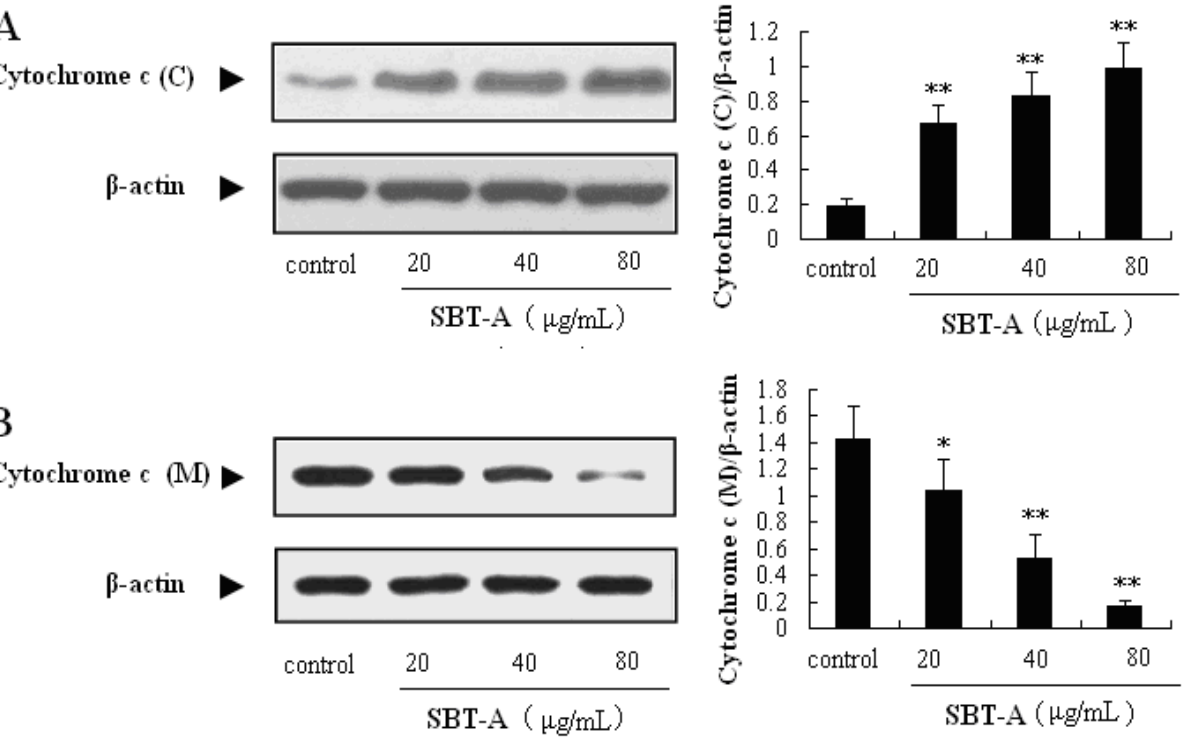
Figure 5. Effects of SBT-A on expressions of cytochrome c, cleaved-caspase-3 (C-capase-3), and cleaved-caspase-9 (C-caspase-9) proteins on A549 cells. Cytochrome c (C) and cytochrome c (M) mean expressions of cytochrome c in cytoplasm and mitochondria, respectively. A549 cell lines were treated with low to high concentrations of SBT-A (20, 40, and 80 μ g/mL) for 48 h, then, the different proteins levels were measured by western blotting, respectively. The data are represented as mean ± S.D ( n = 4). * p < 0.05 and ** p < 0.01 vs .